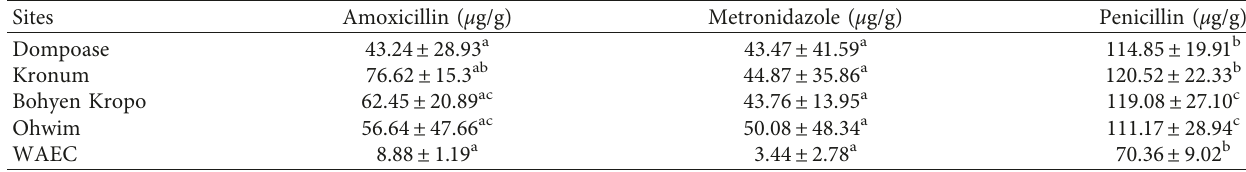
Table 4: Levels of antibiotics in soil samples.